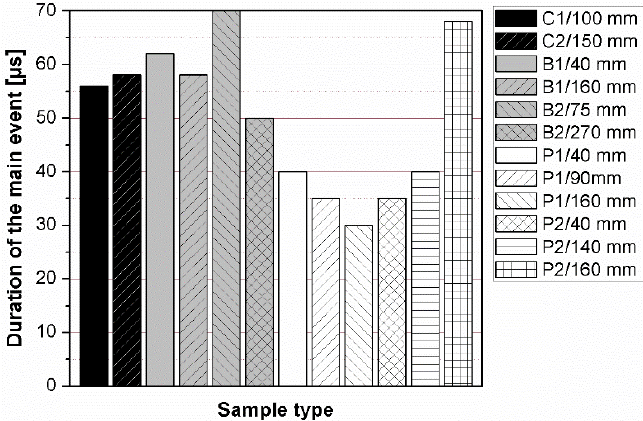
Figure 15. Changes in duration time of the main event depending on the sample geometry.